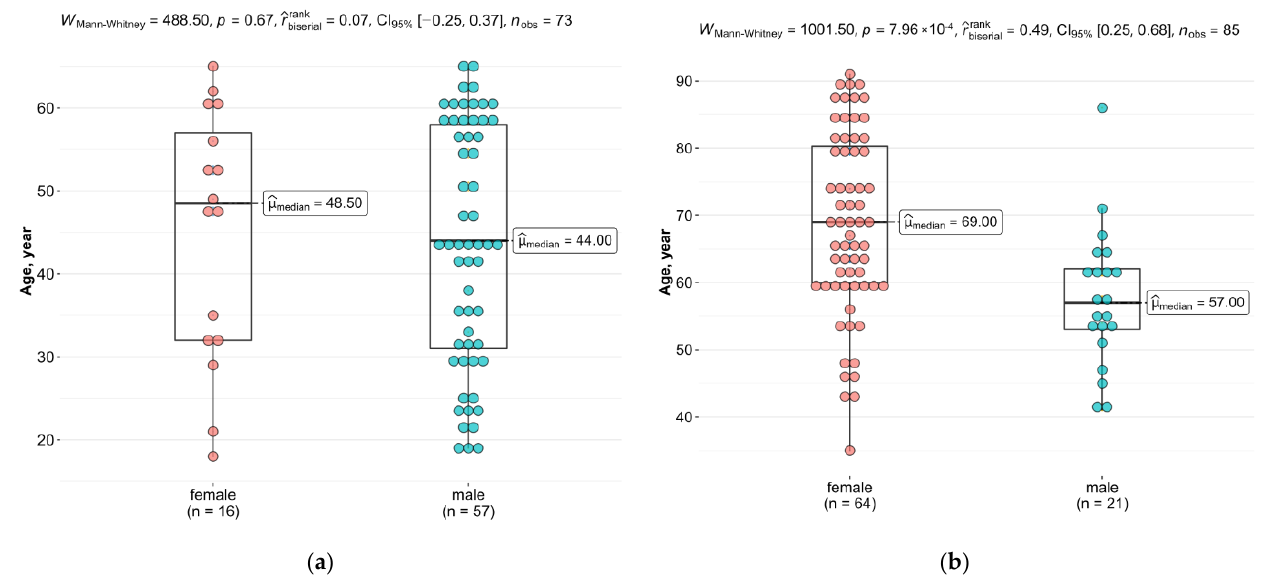
Figure 2. The distribution of samples by gender and age: ( a ) Case 1 group; ( b ) Case 2 group.